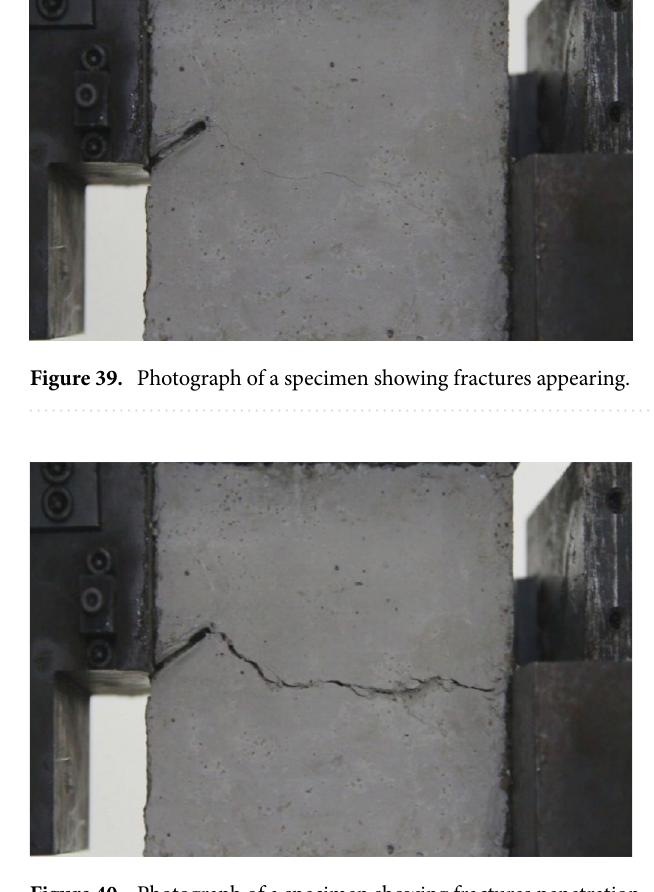
Figure 40. Photograph of a specimen showing fractures penetration.